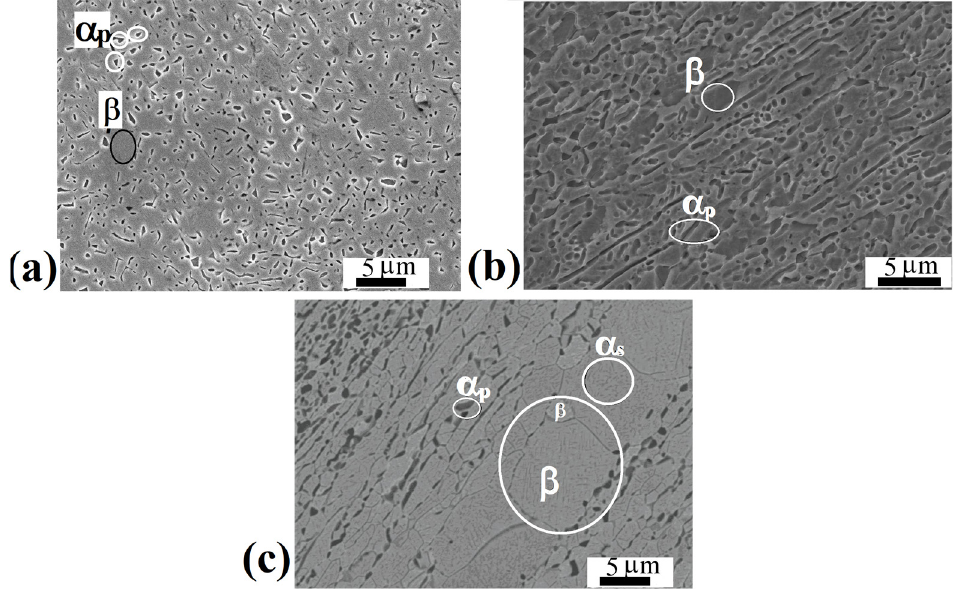
Figure 2. SEM images of the Ti-15Mo alloy: ( a ) in the initial state, the cross-section of the rod; ( b ) in the initial state, the longitudinal section of the rod; ( c ) after annealing at 600 °C, 1 h, WQ, longitudinal section of the rod.